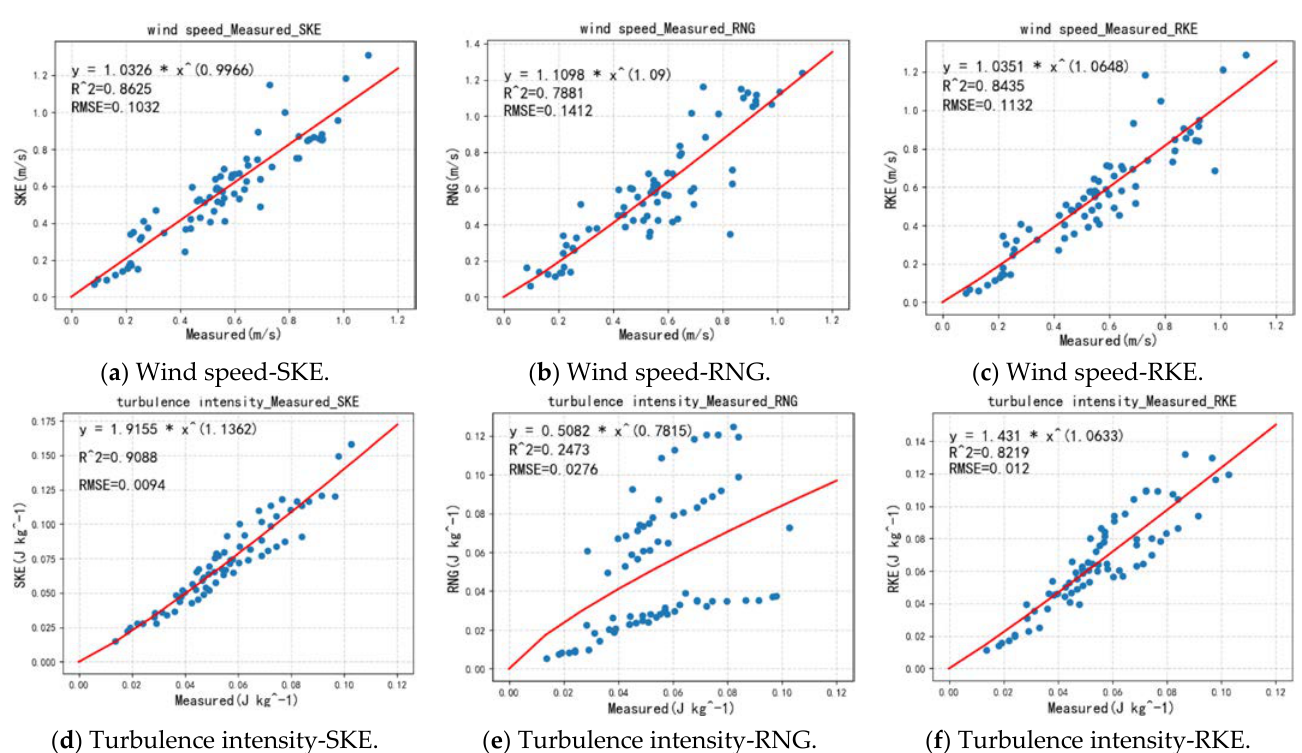
Figure 15. Comprehensive reliability analysis of actual measurement and simulation.